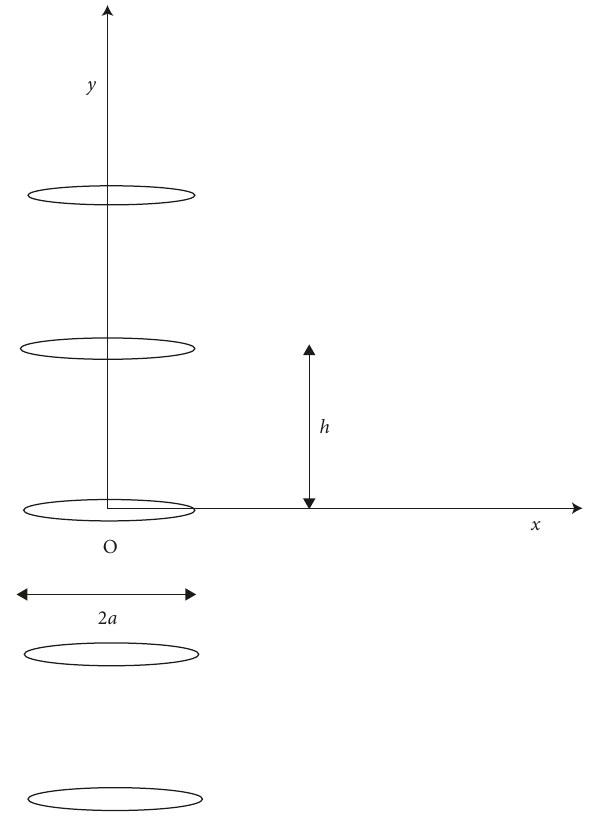
Figure 1: Stack of parallel Griffith-type shear